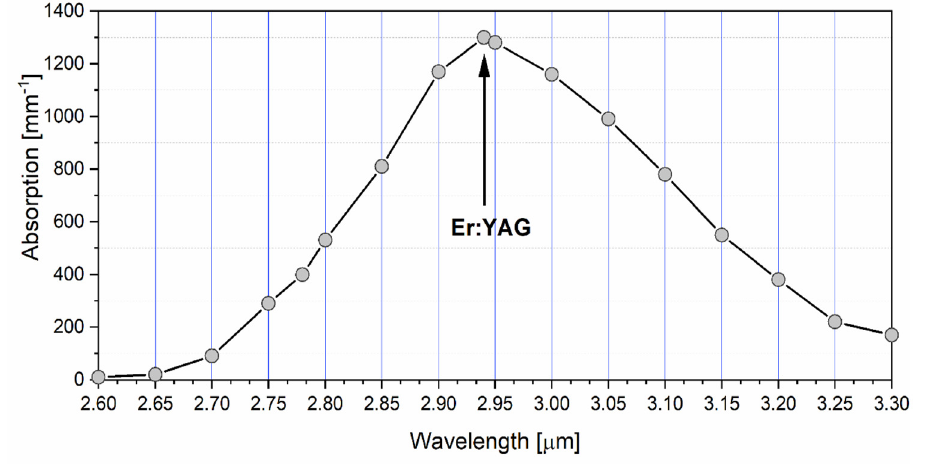
Figure 1. The absorption curve of water in the middle infrared region. The position of Erbium-doped Yttrium Aluminium Garnet (Er: YAG) laser (2.94 µ m) used for hard-tissue ablation has been shown in the plot (based on Handbook of optical materials) [36].